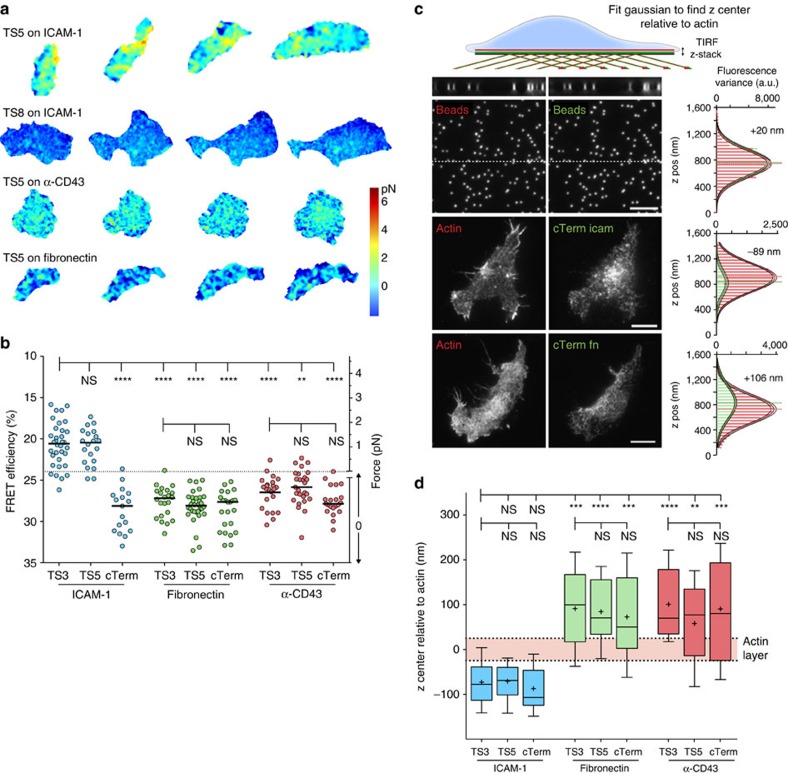
Integrin tension depends on interaction with specific ligand.(a) Representative FRET images over 60 s of migrating Jurkat T cells expressing indicated tension sensor constructs. Images are corrected for photobleaching. Images are from three independent experiments. (b) Whole-cell FRET levels in migrating Jurkat T cells with 100 ng ml−1 SDF-1α. Circles represent individual cells from three independent experiments with median shown as a line. Kruskal–Wallis with Dunn's multiple comparison test of differences between indicated conditions yielded P-values: ****P<0.0001, ***P≤0.001, **P≤0.01. (c) Representative images of focal plane in TIRF z-stacks (50 nm step) of Lifeact-mCherry and TS-mVenus with distribution of fluorescence variance and Gaussian fits with indicated relative difference of the whole-cell distribution. The dotted lines across the submicron bead (100 nm) images are shown as side views at the top. Scale bar, 5 μm. (d) Relative differences of integrin z center to actin after chromatic aberration correction (N=15,13,15,16,20,22,16,16,11). Box plots show the 5–95 percentile range (whiskers) of observations with median as line, mean as plus sign, and 25–75 percentile range boxed. Mean±s.e.m. from left: −42.9±12.4, −40.8±11.4, −57.2±12.7, 121.3±24.0, 114.5±17.5, 102.8±20.33, 130.8±20.3, 88.1±23.7, 120.5±32.2. Kruskal–Wallis with Dunn's multiple comparison test of differences between indicated conditions yielded P-values: ****P<0.0001, ***P≤0.001, **P≤0.01.